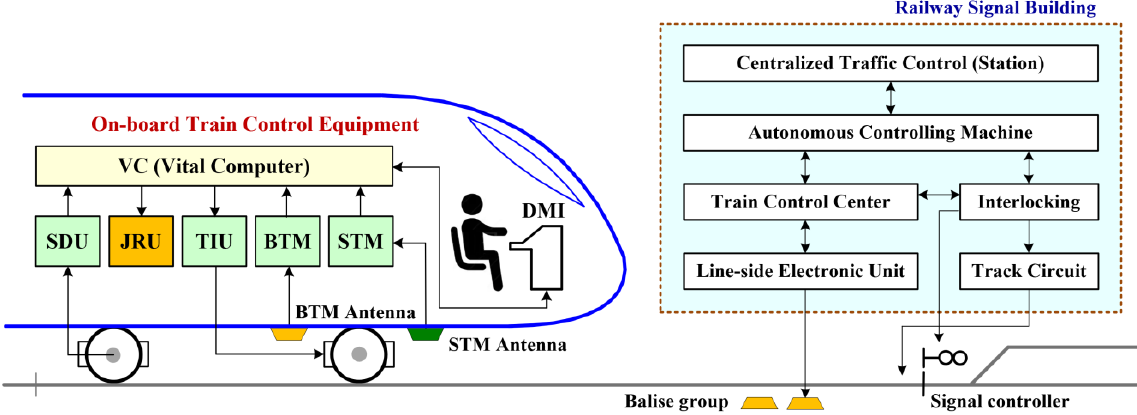
Figure 1. Structure of the CTCS2-200H on-board train control equipment.